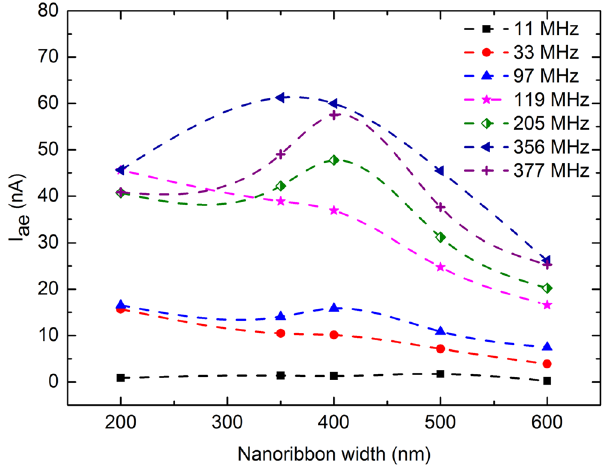
Figure 4. Acoustoelectric current as a function of graphene nanoribbon width, for several SAW frequencies. As GNR width increases, the acoustoelectric current at a given frequency generally decreases. Dashed lines are guides to the eye.